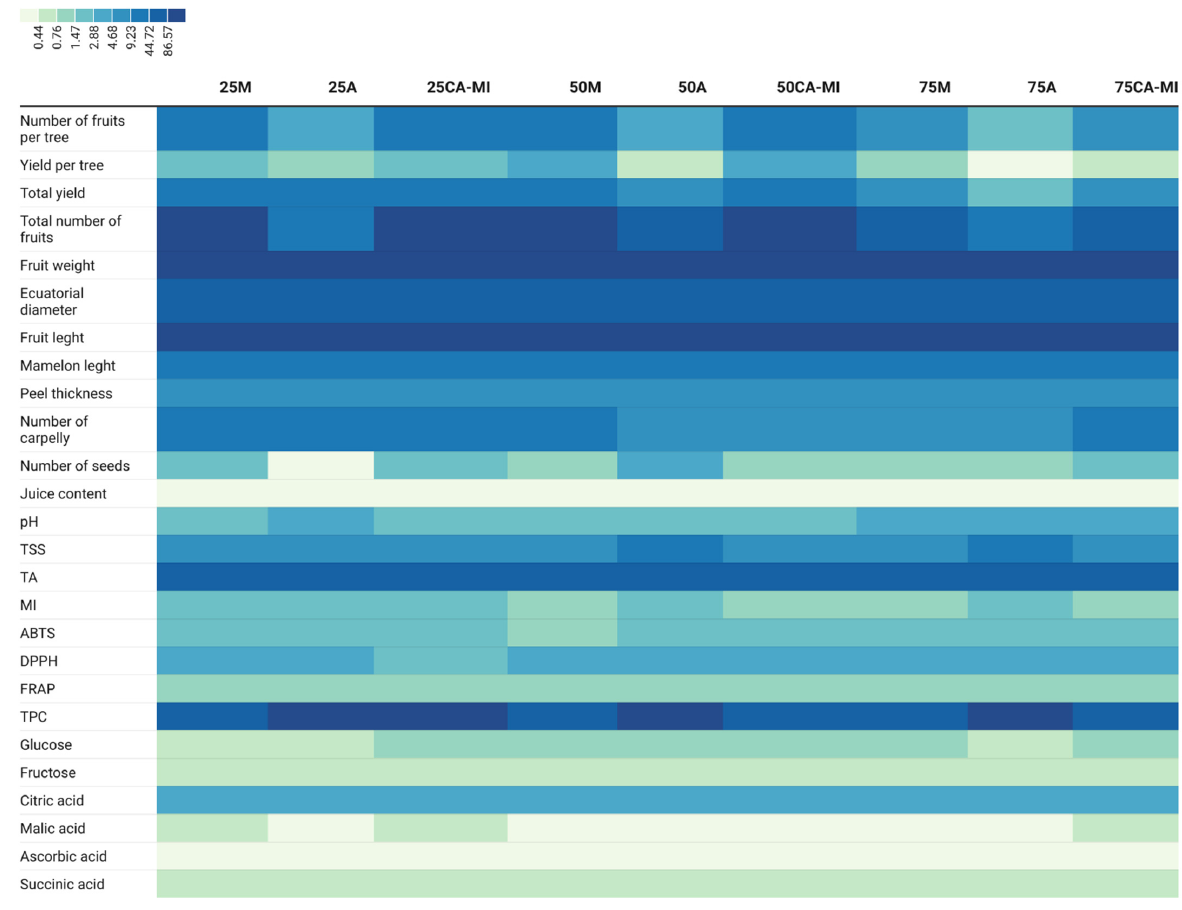
Figure 1. Differential heatmap of the morphological characteristics and chemical parameters evaluated in ‘Verna’ lemons depending on the substrate, where 25, 50, and 75 represent the content of marine sediment—being 25%, 50% and 75%, respectively; and the rootstock used, where CM, CA-MI, and CA represent the Citrus macrophylla rootstock Citrus aurantium/Citrus sinensis, and Citrus aurantium, respectively (Table 1).